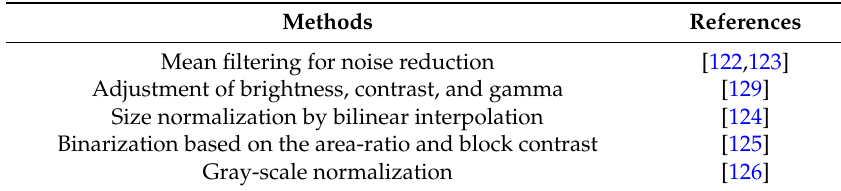
Table 11. Methods for preprocessing in the serial number recognition process flow.